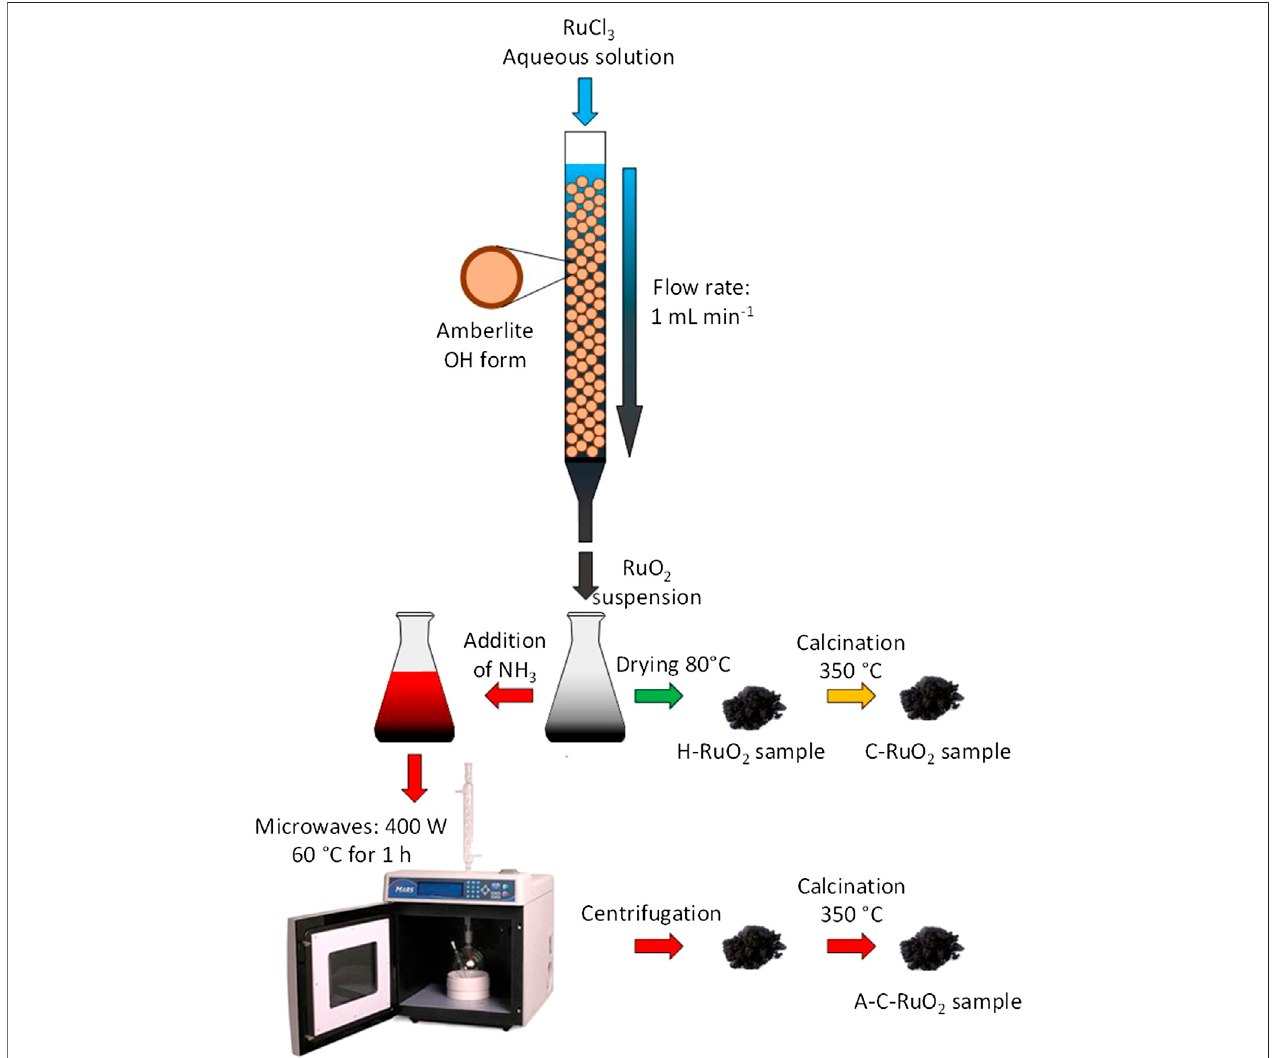
FIGURE 1 | Schema of the synthesis processes of C-RuO 2 H-RuO 2 and A-C-RuO 2 samples.